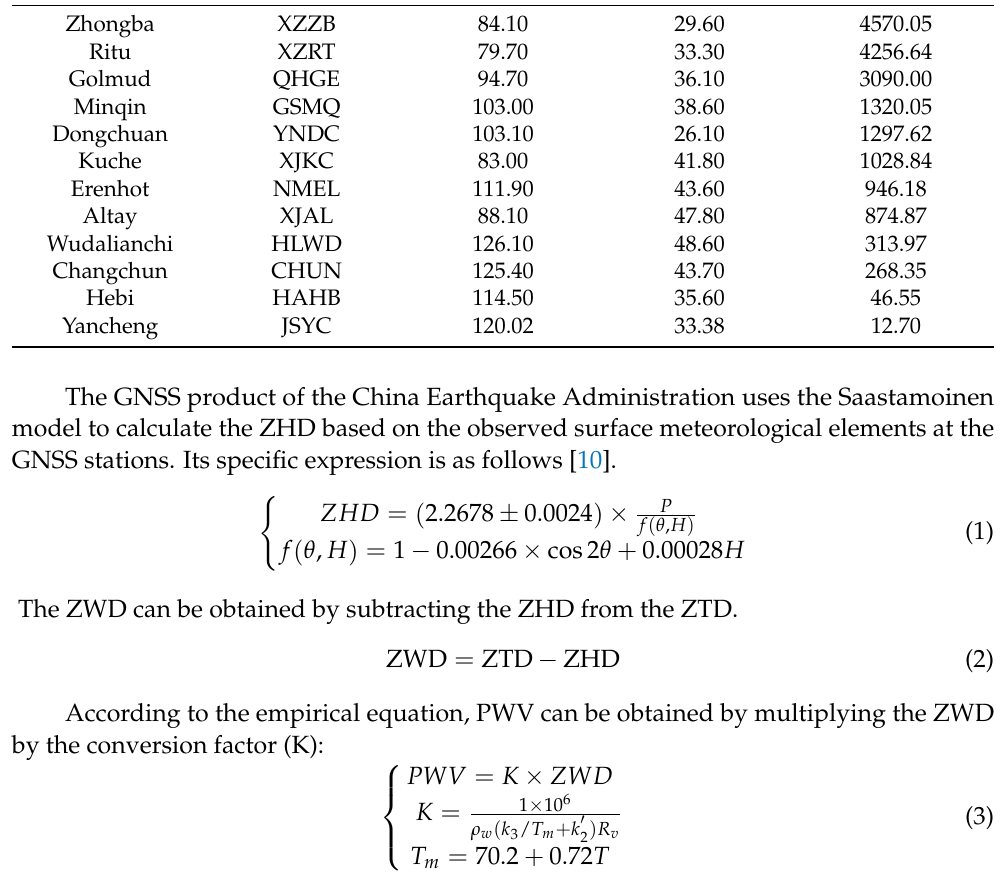
Table 2. Locations of 12 selected GNSS stations for verification in the China region.